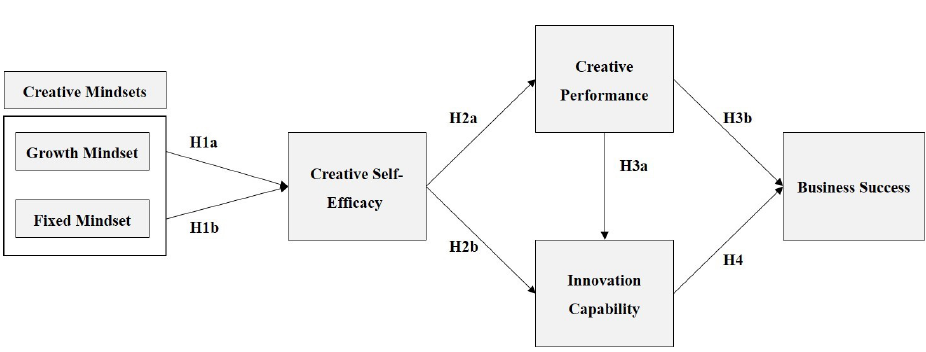
Figure 1. Research framework (source: created by